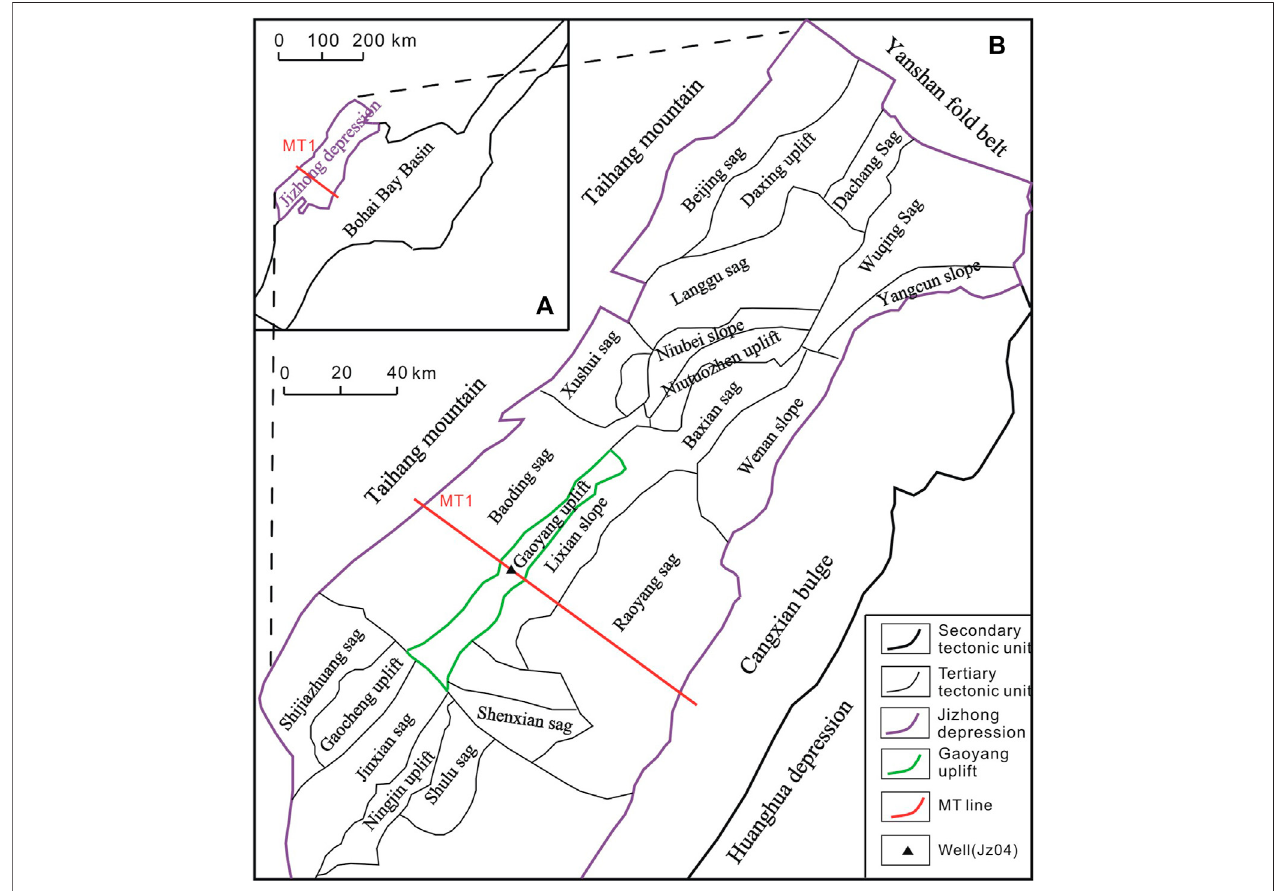
FIGURE 1 | (A) Location map of the Jizhong depression. (B) Schematic diagram of tectonic units in the Jizhong depression.